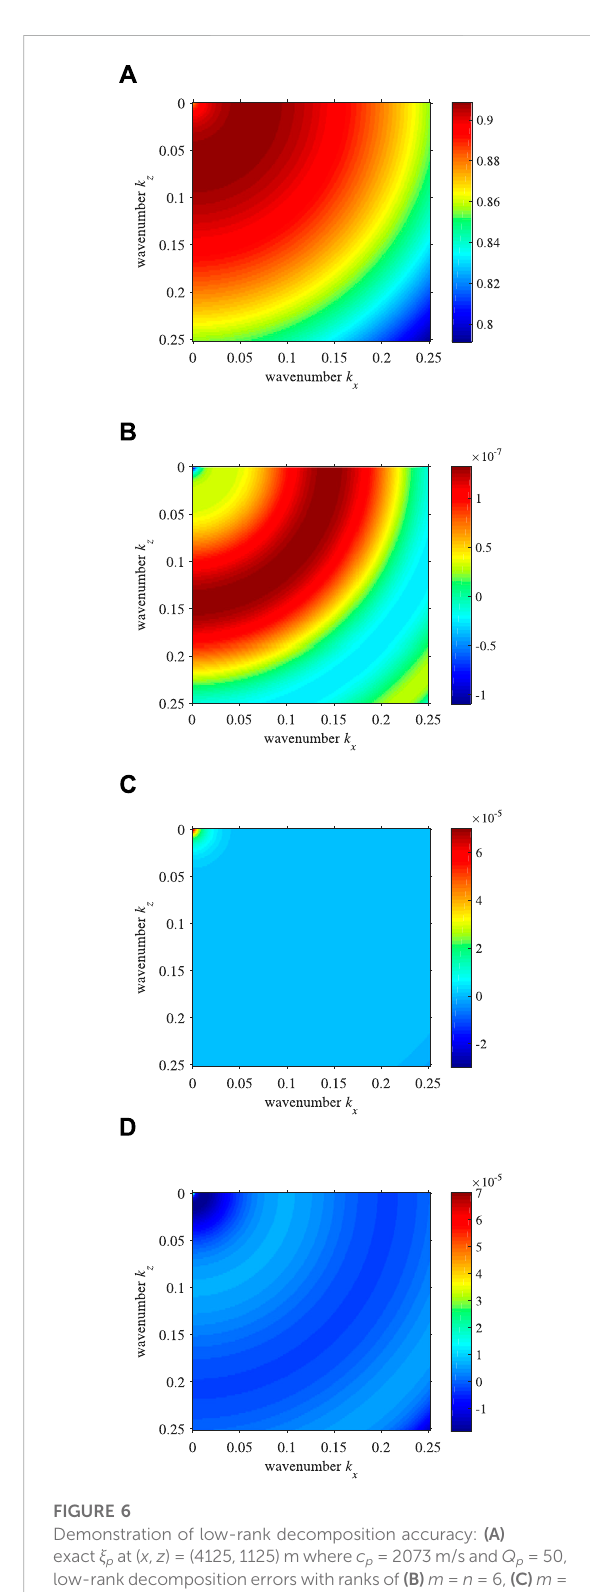
FIGURE 6 Demonstration of low-rank decomposition accuracy: (A) exact ξ p at( x , z )=(4125,1125)mwhere c p =2073m/sand Q p =50, low-rankdecompositionerrorswithranksof (B) m = n =6, (C) m = n = 5, and (D) m = n =